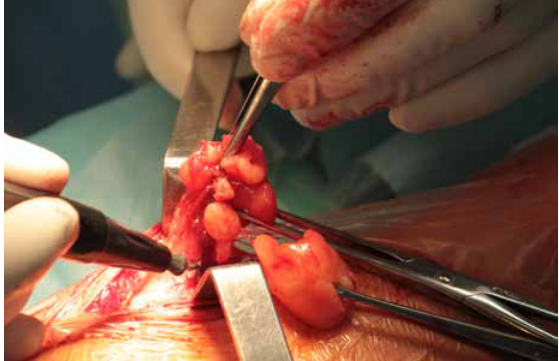
Figure 2. Surgical excison of